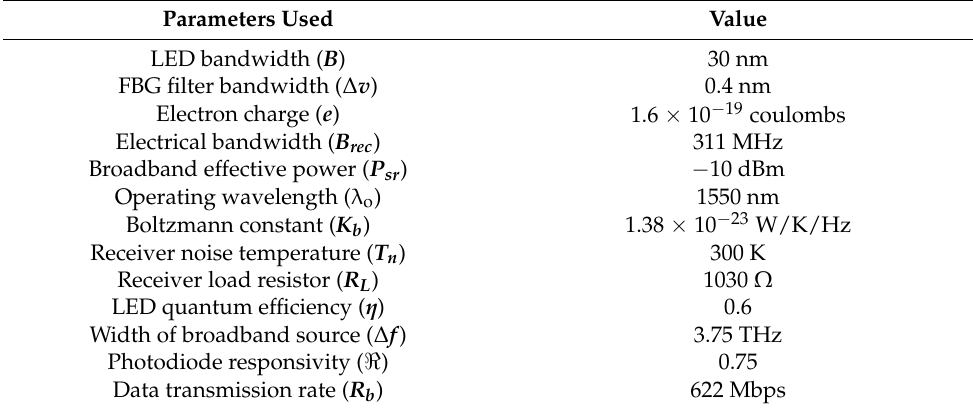
Table 4. Parameters used for numerical analysis and simulations of the SAC system with the 2D- BIBD